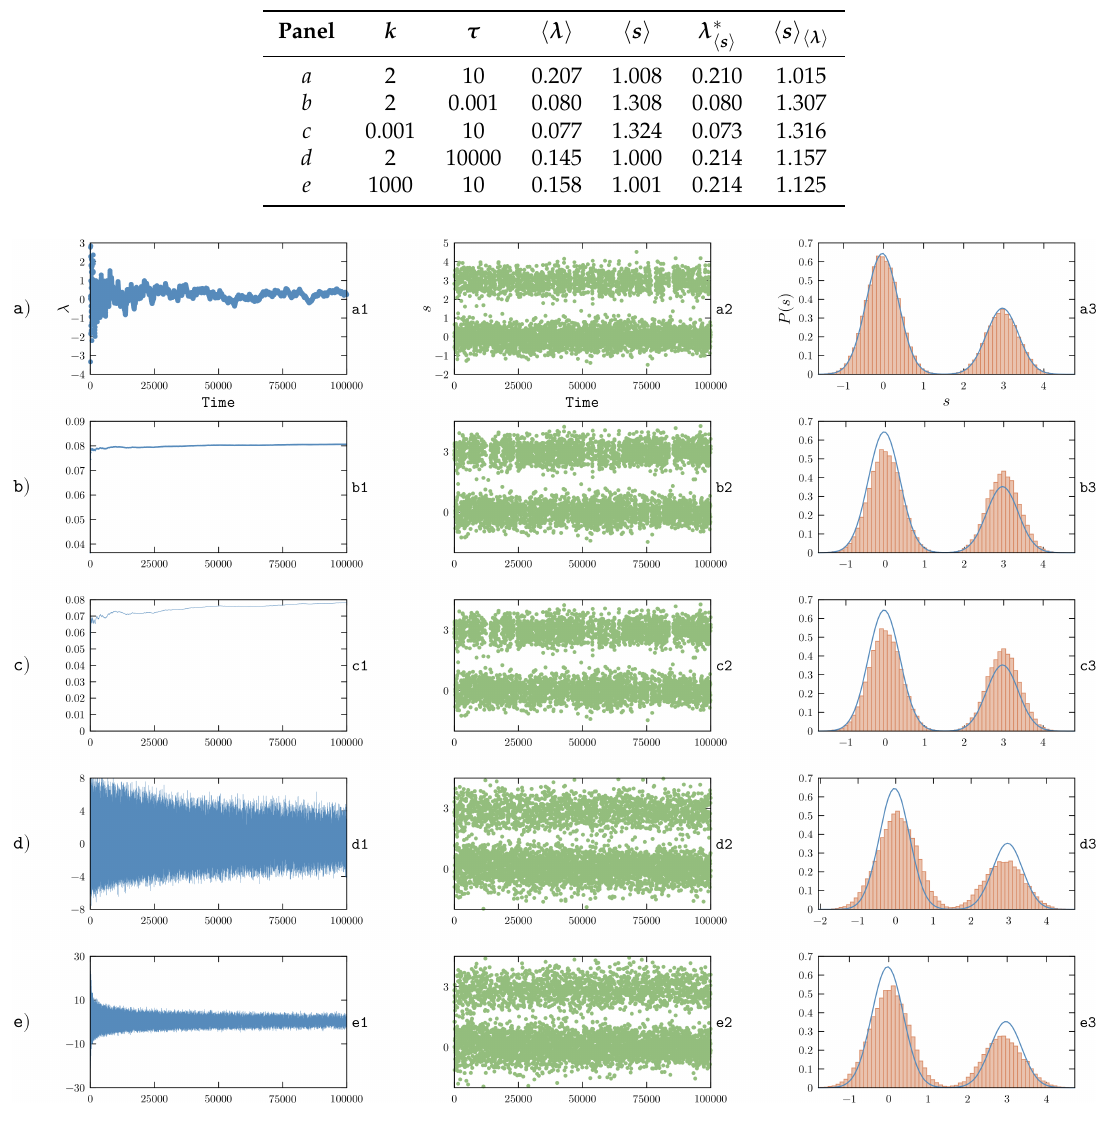
Table 1. Summary of the results obtained with the Langevin model, including learning parameters ( k and τ ) and average (cid:104) λ (cid:105) and (cid:104) s (cid:105) computed over the second half of the simulation. In addition, we report the exact Lagrangian multiplier λ ∗ required to enforce an average equal to (cid:104) s (cid:105) and the exact (cid:104) s (cid:105) average (cid:104) s (cid:105) (cid:104) λ (cid:105) corresponding to a Lagrangian multiplier (cid:104) λ (cid:105) . The last two columns are obtained by using the analytical solutions described in Section 4. Panel labels match those in Figure 5.